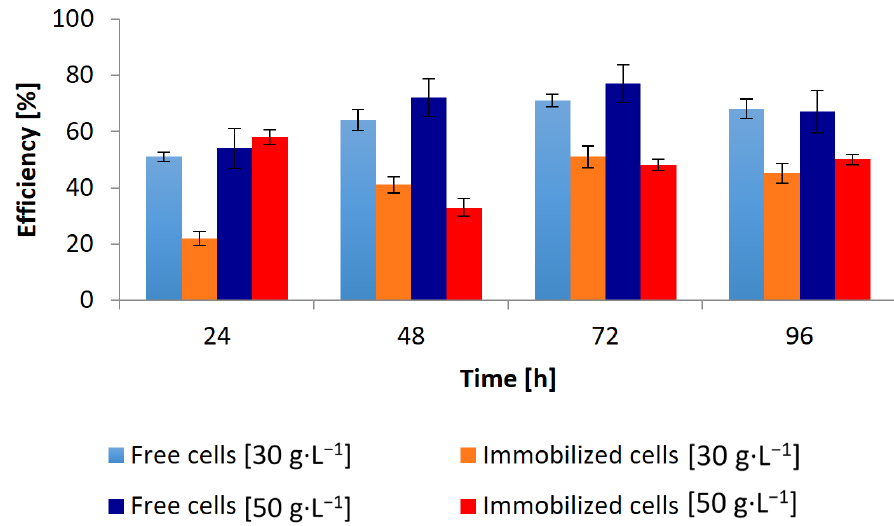
Figure 10. Efficiency of the bioconversion of waste glycerol by free or immobilized cells of G. oxydans in the medium with different initial contents of the substrate. [30 g·L −1 ]